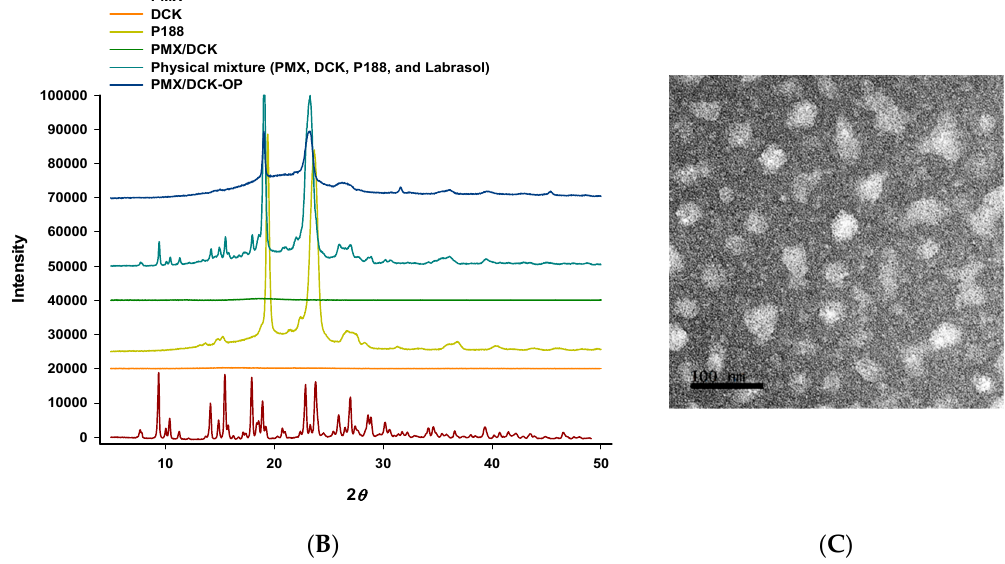
Figure 3. ( A ) A structural diagram of the ion-paired complex of PMX and N α -deoxycholyl- L -lysyl- methylester (DCK), and a schematic representation of PMX/DCK-OP micelles. ( B ) Powder X-ray diffractograms of PMX, DCK, P188, and PMX/DCK; a physical mixture of PMX, DCK, P188, and Labrasol; and PMX/DCK-OP. ( C ) Transmission electron micrograph of PMX/DCK-OP micelles. Scale bar: 100 nm.